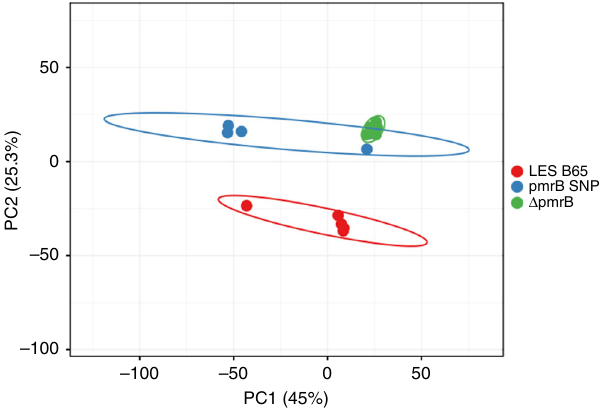
Fig. 6 Principal component biplot of LESB65, pmrB SNP and Δ pmrB . Unit variance scaling is applied to rows; SVD with imputation is used to calculate principal components. X axis and Y axis show principal component 1 and principal component 2 that explain 45% and 25.3% of the total variance, respectively. Prediction ellipses are such that with probability 0.95, a new observation from the same group will fall inside the ellipse. N = 15 data